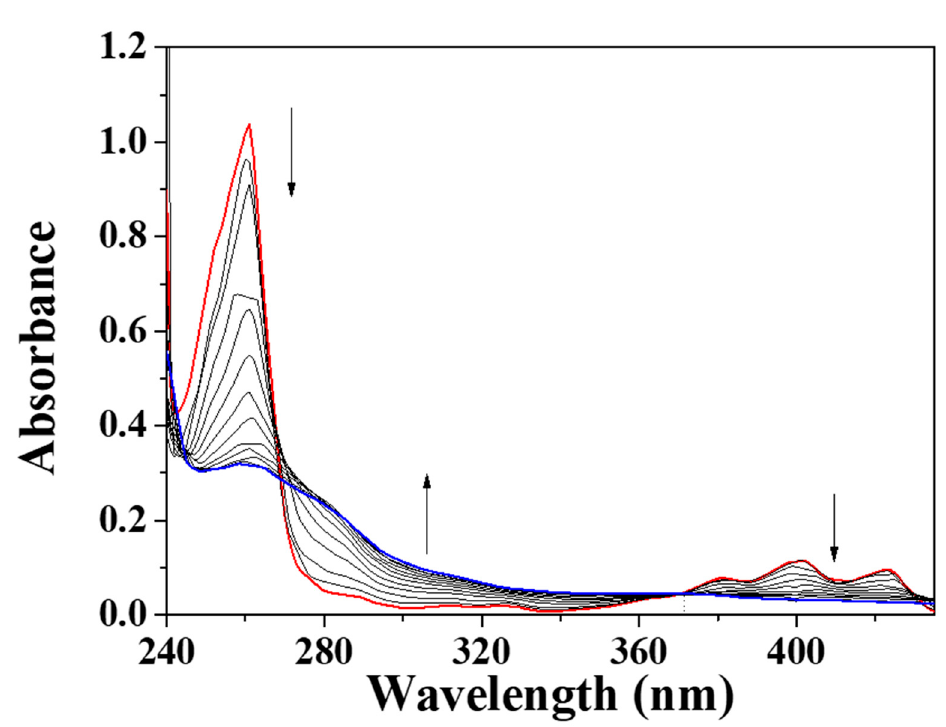
Figure 3. UV-vis variations of probe BK (1 × 10 − 5 M) with di ff erent concentrations of ClO − .